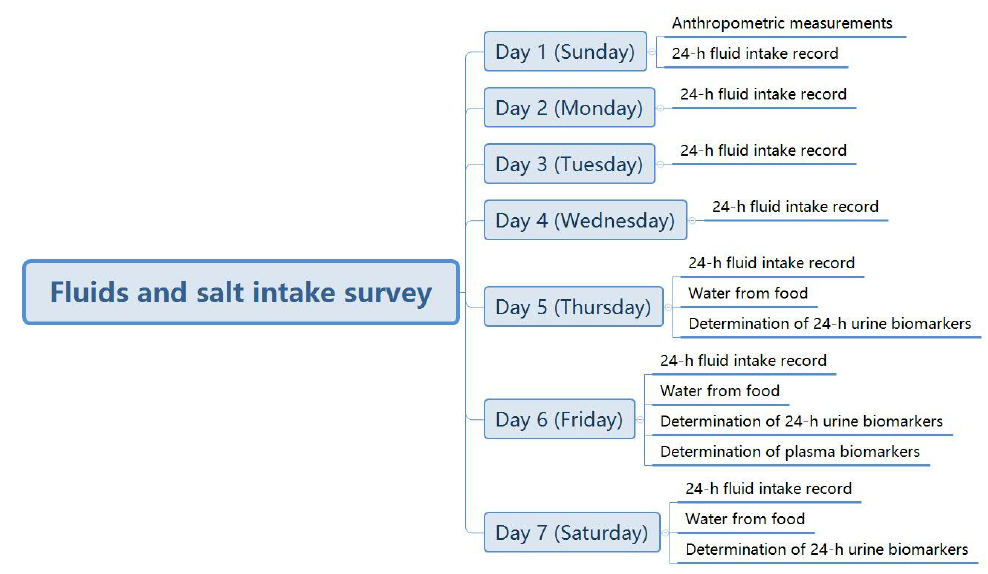
Figure 2. The study procedure.